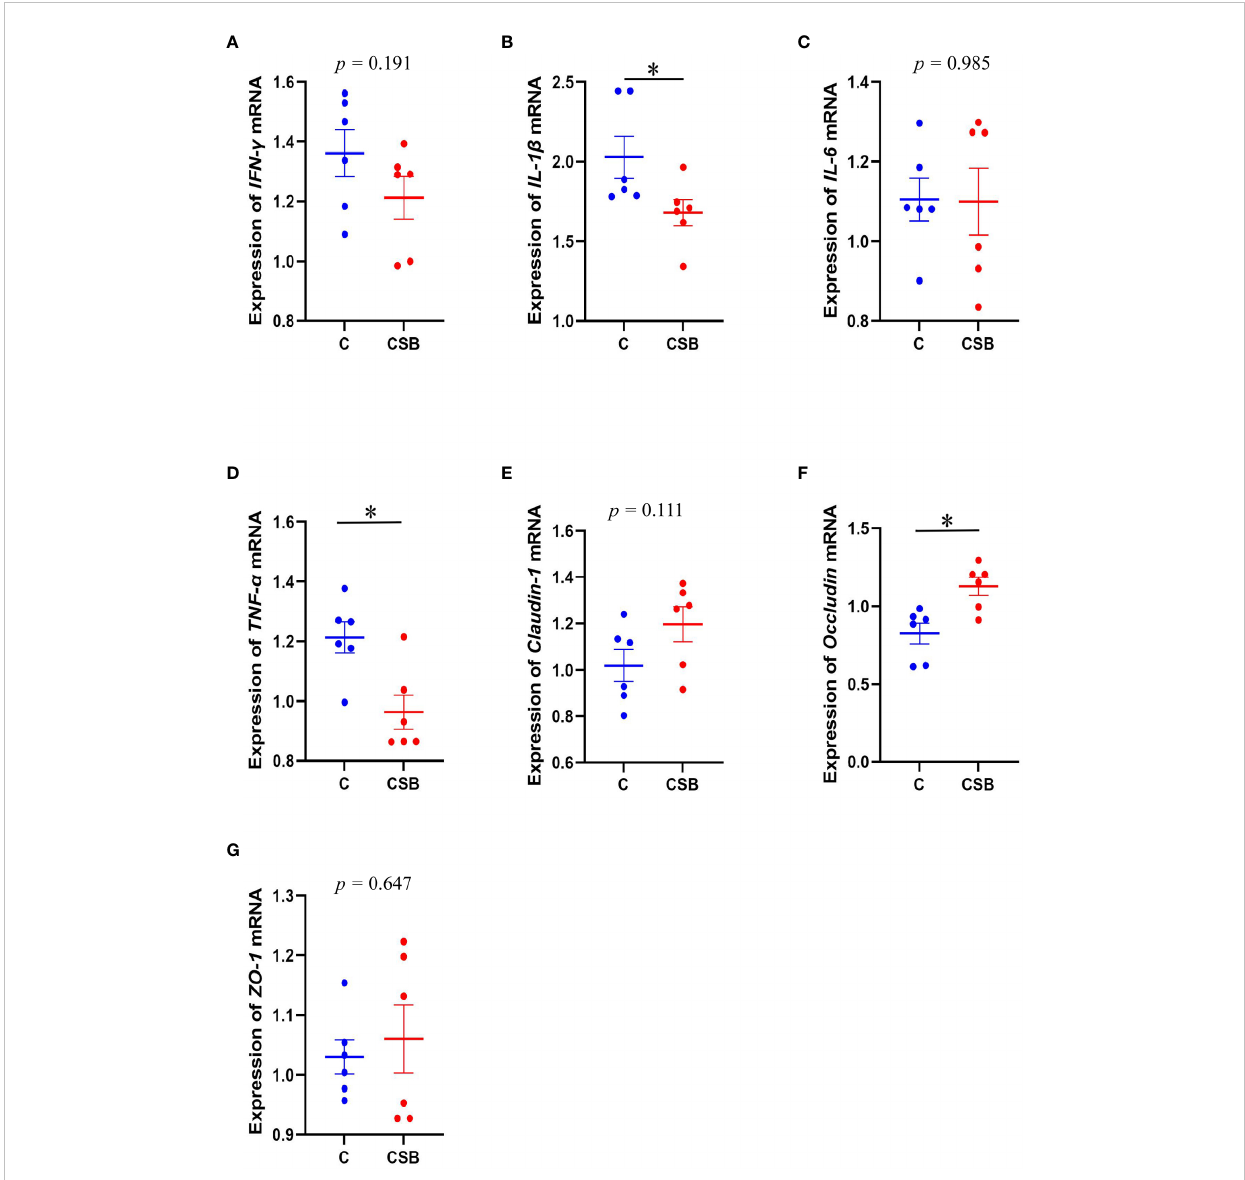
FIGURE 4 Effects of dietary supplementation of coated sodium butyrate (CSB) on the expression of immune-related genes in the spleen and the ileal tight junction protein gene of laying ducks. (A) Interferon- g ( IFN- g ). (B) Interleukin-1 b ( IL-1 b ). (C) Interleukin-6 ( IL-6 ). (D) Tumor necrosis factor